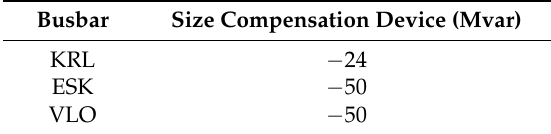
Table 6. The recommendation of the placement for reactive power devices, based on the